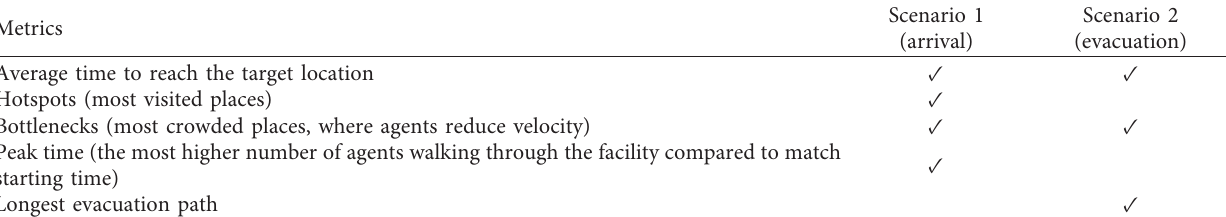
Table 2: Example